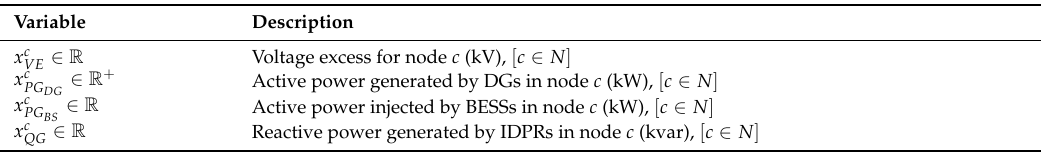
Table 17. Summary of variables (SS